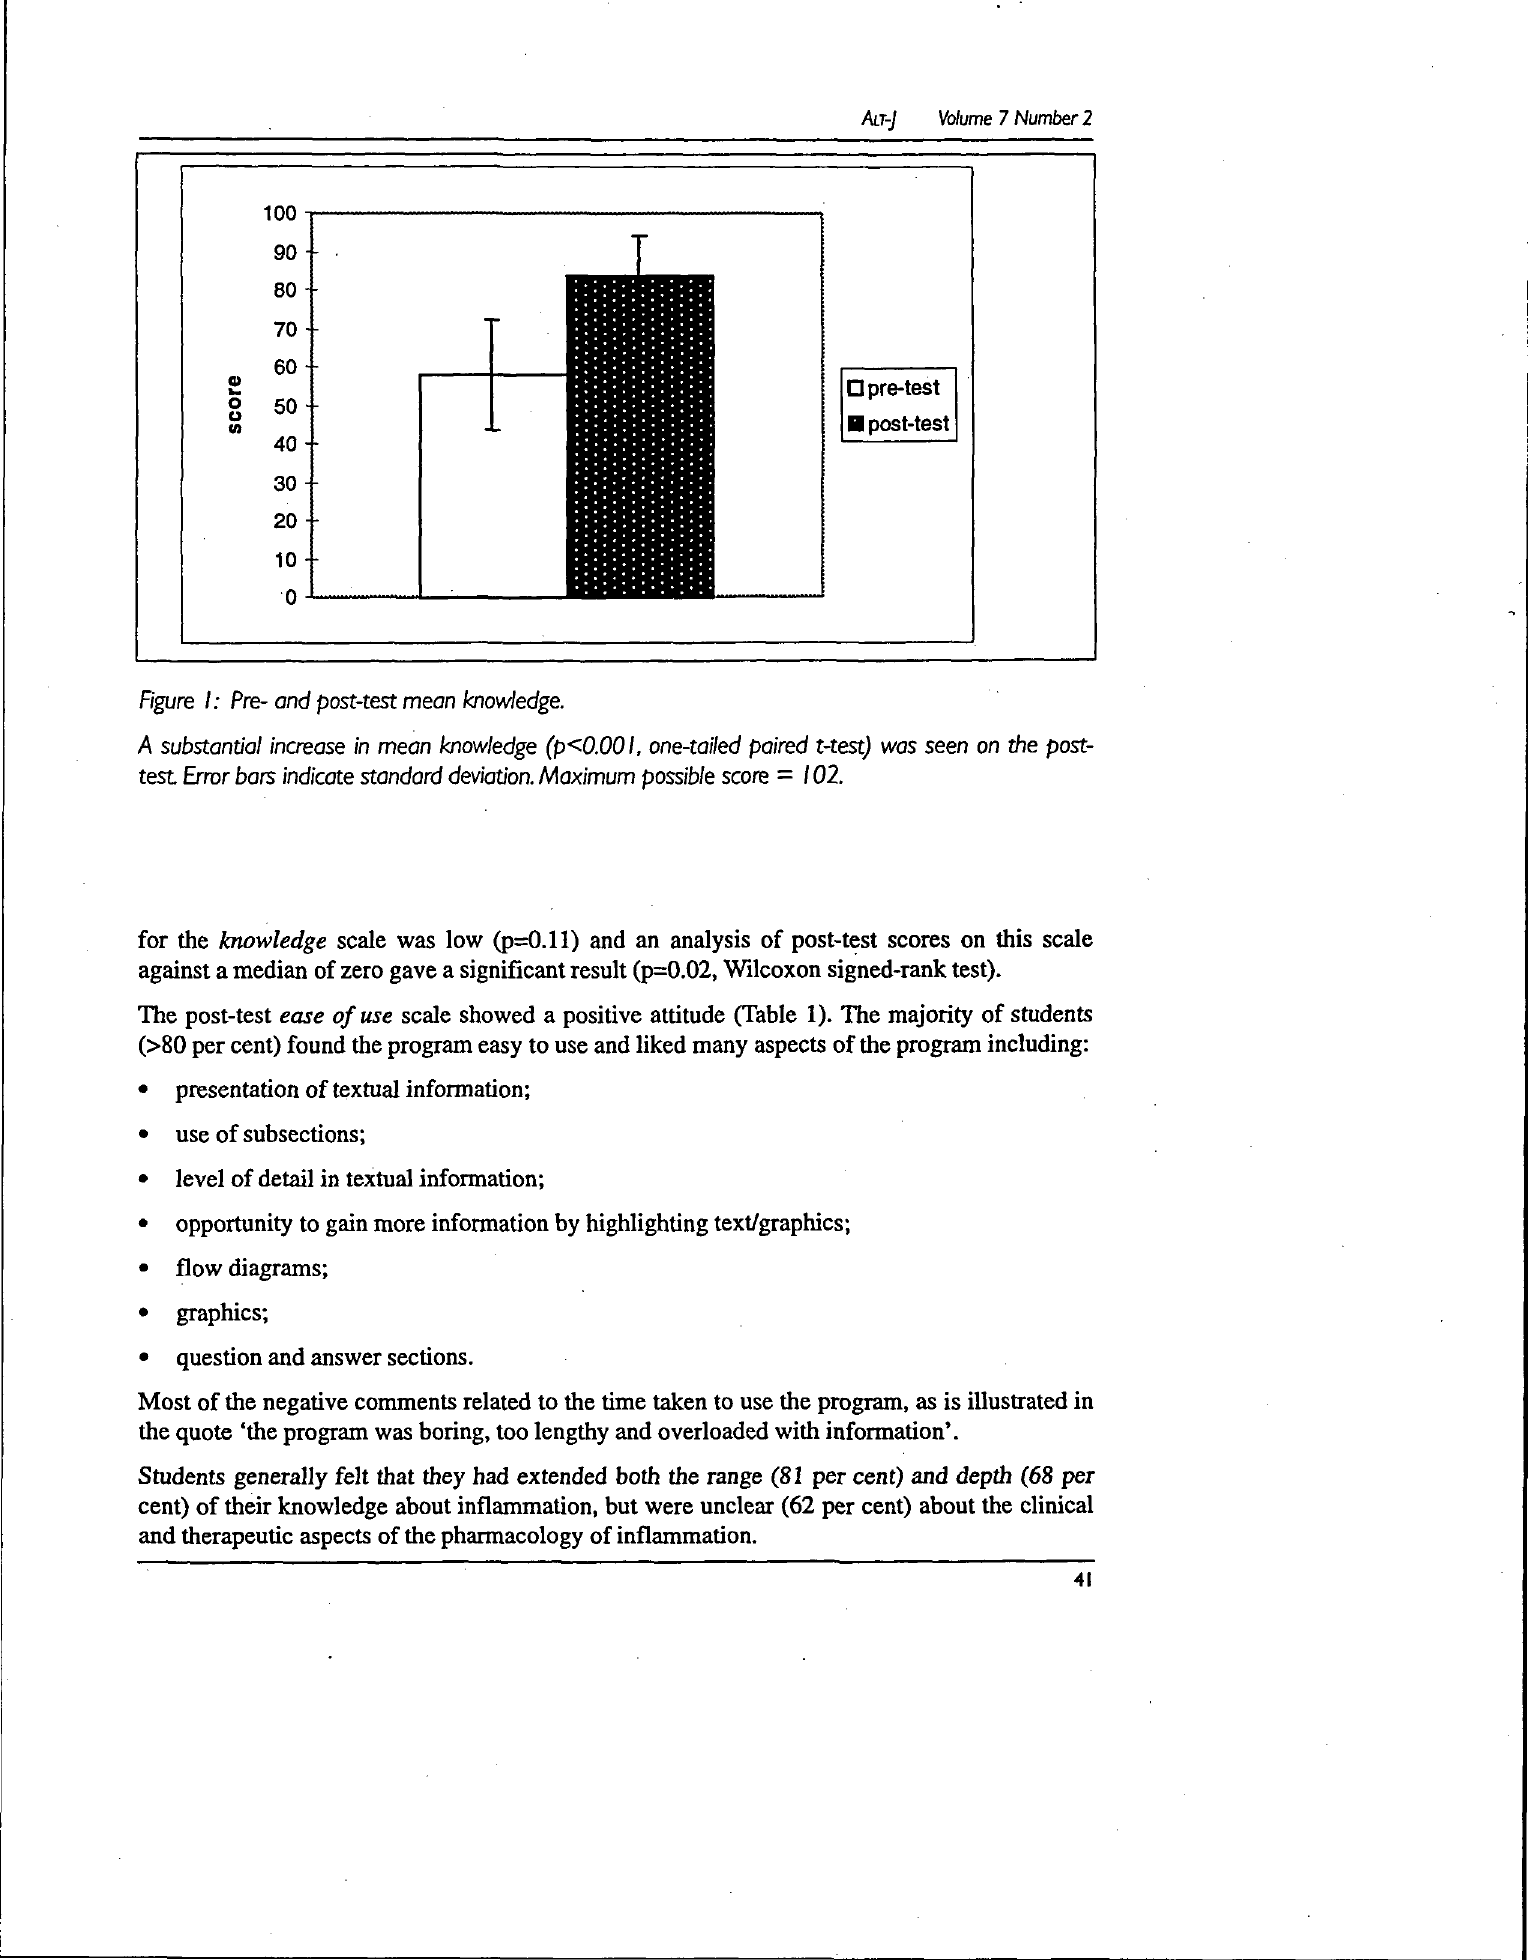
Figure /: Pre- and post-test mean knowledge. A substantial increase in mean knowledge (p<0.00l, one-tailed paired t-test) was seen on the post- test Error bars indicate standard deviation. Maximum possible score = /